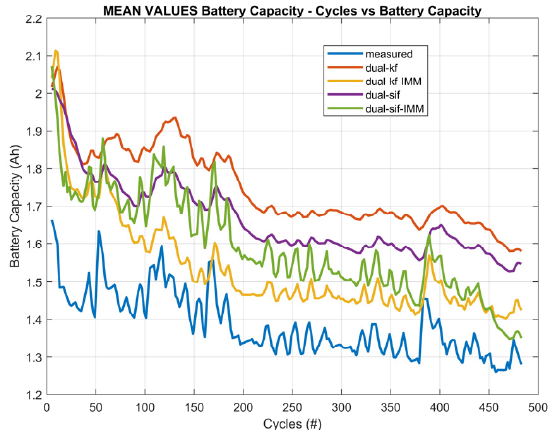
Figure 20. Battery capacity estimation results of each algorithm.